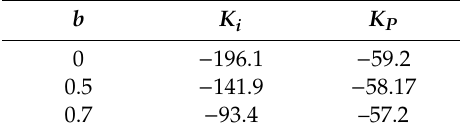
Table 10. PI controller parameters for different values of factor b .